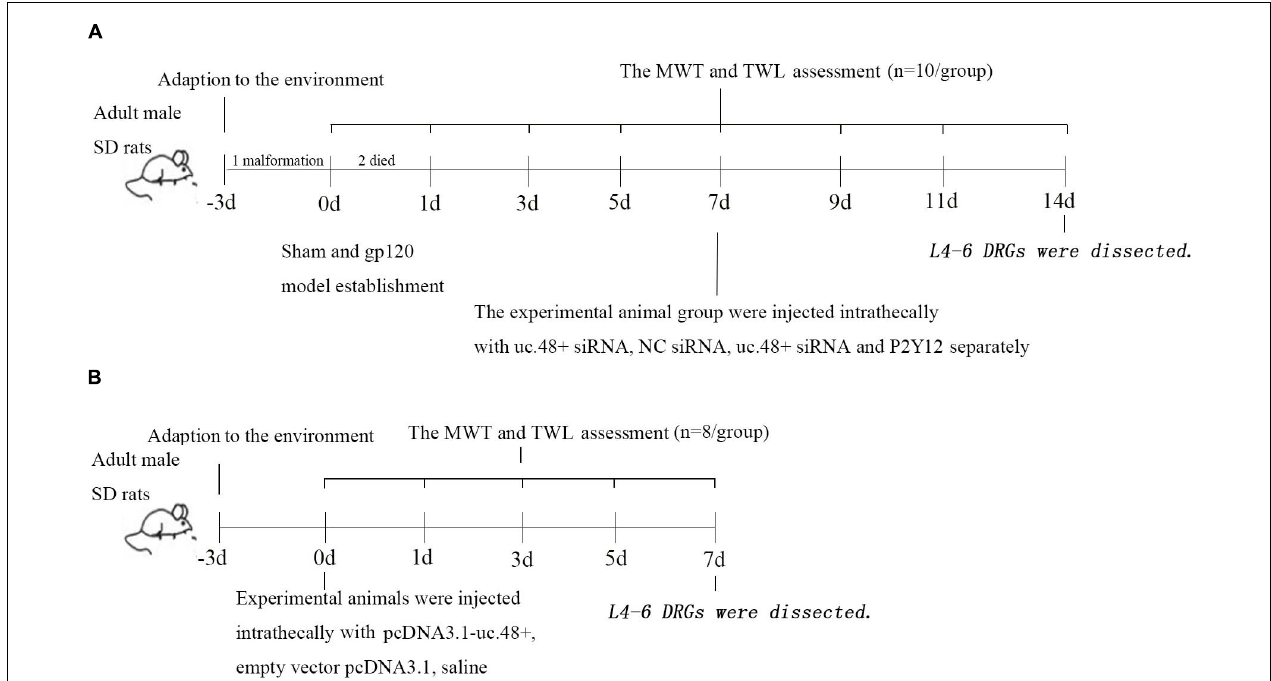
FIGURE 1 | Timeline of study design. Timeline of gp120 animal model (A) and uc.48+ overexpression animal model (B)